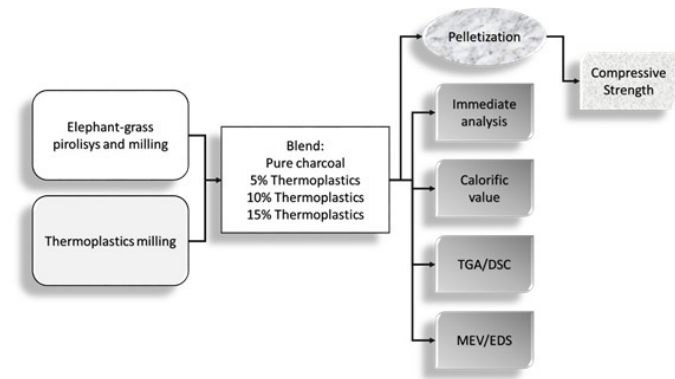
Figure 1. Schematic diagram of sample preparation and analysis.